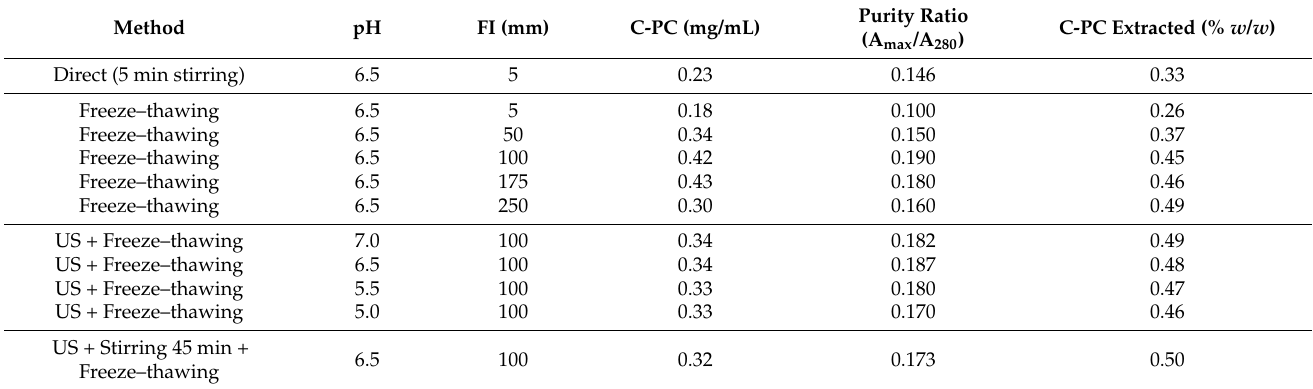
Table 1. Extraction processes assayed for C-phycocyanin recovery (US stands for ultrasound